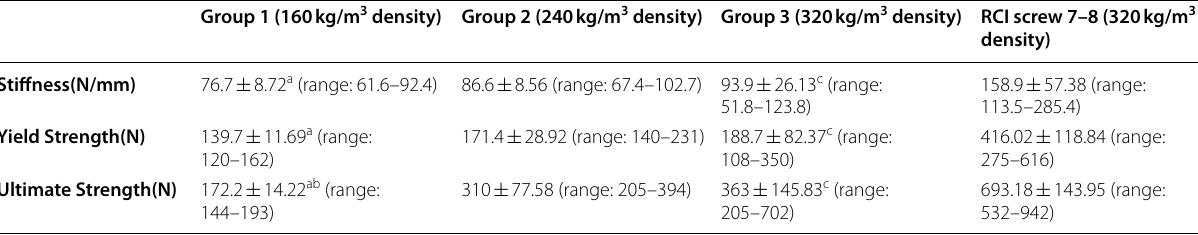
a Significantly different from group 2 b Significantly different from group 3 c Significantly different from screw